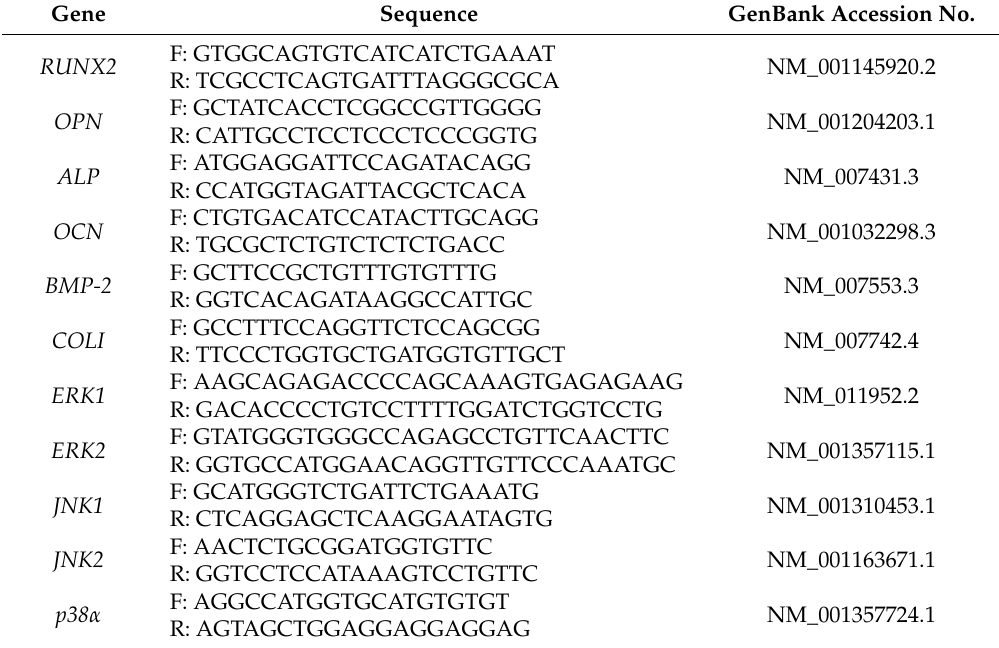
Table 1. The primer sequences of